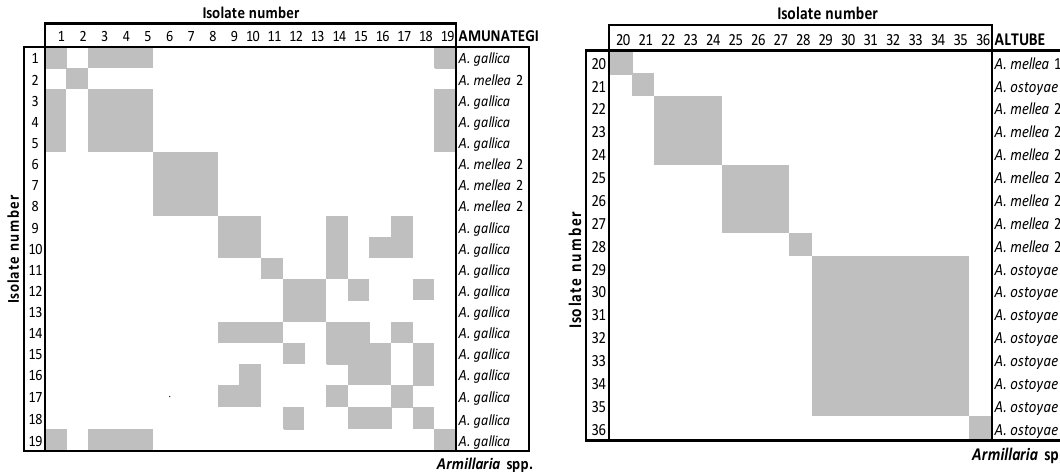
Figure 6. Fungal population analysis by mycelial pairings. Grey squares indicate strains belonging to the same SCG; white squares correspond to non-compatible strains. Paired sets shown on the left correspond to samples collected in Amunategi, paired sets shown on the right correspond to samples collected in Altube.